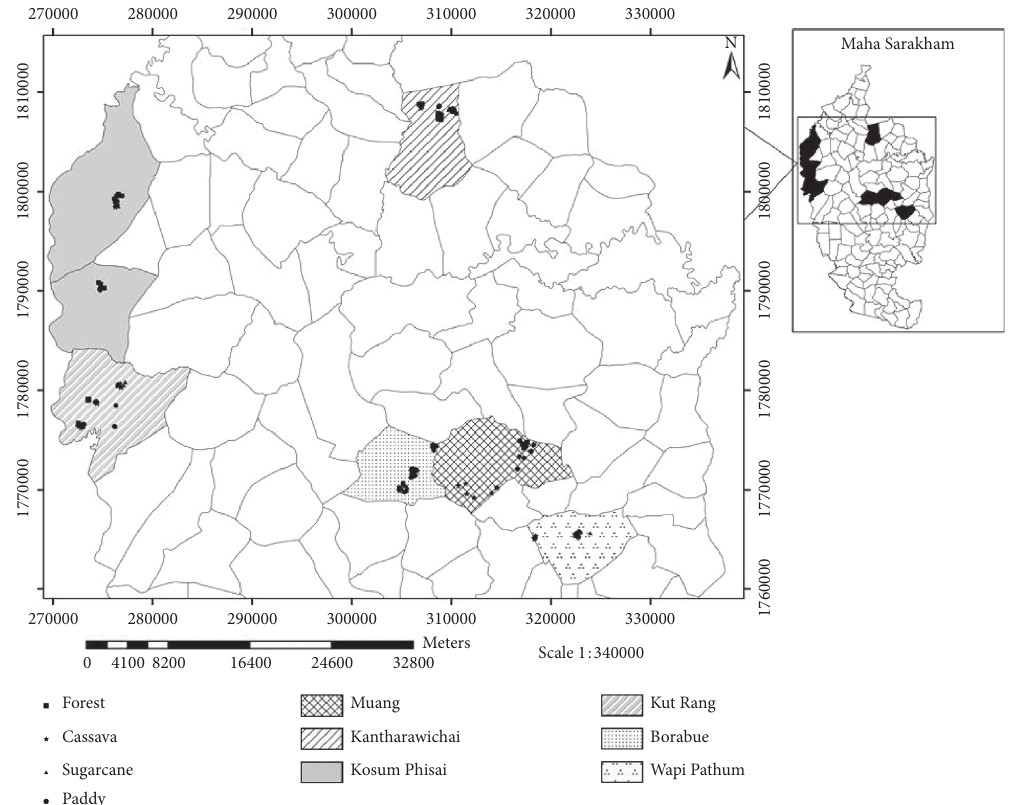
Figure 1: A map presenting study sites in Maha Sarakham province of Northeast Figure 2. The climate data were provided by the north- –eastern meteorological center in Maha Sarakham province.